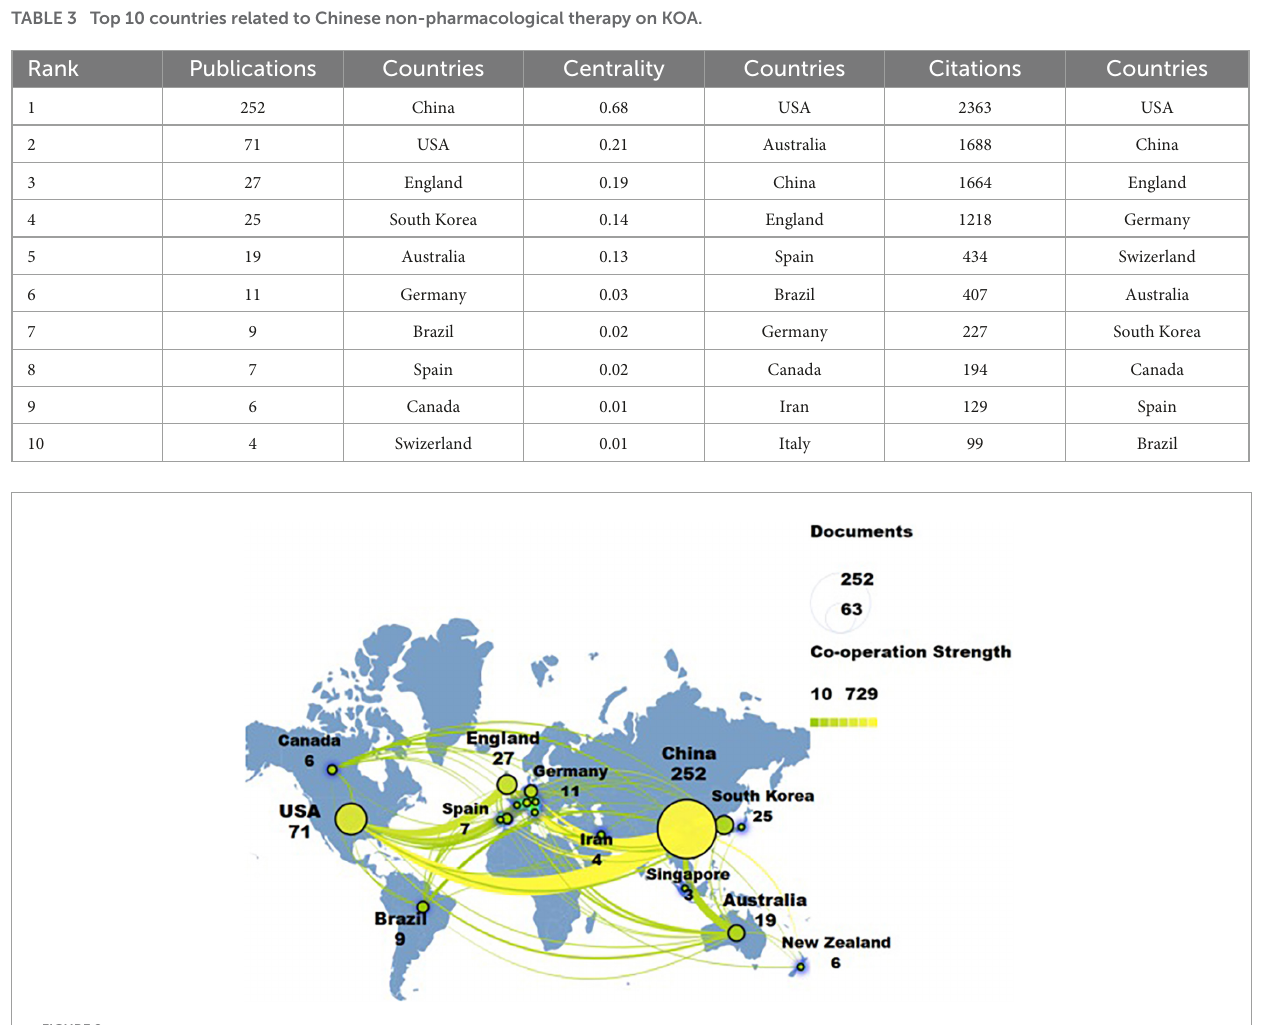
FIGURE2 The collaboration network of countries researching traditional Chinese non-pharmacological therapies on knee osteoarthritis